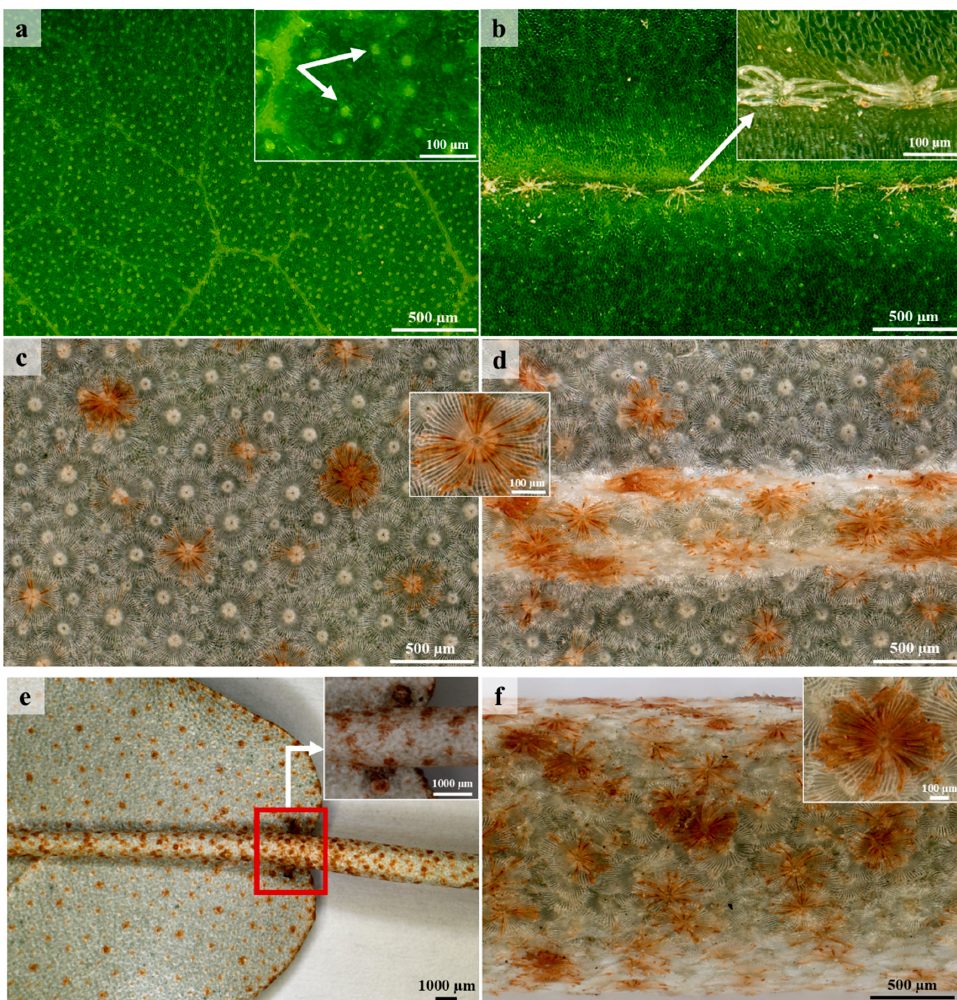
Figure 1. Stereomicrographs of stem and leaf surfaces. ( a ) Glabrous lamina showing translucent dots on adaxial surface. ( b ) Stellate trichome along sunken mid-vein on the adaxial surface. ( c ) Lamina of abaxial surface densely covered with lepidote trichomes. ( d ) Mid-vein on abaxial surface covered with lepidote trichomes. ( e ) Extrafloral nectaries present on the mid-vein at the base of the leaf. ( f ) Dense indumentum of lepidote trichomes on stem.